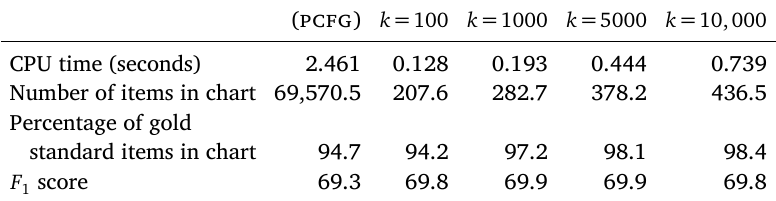
Table 6: Results for different levels of pruning; mean over 1000